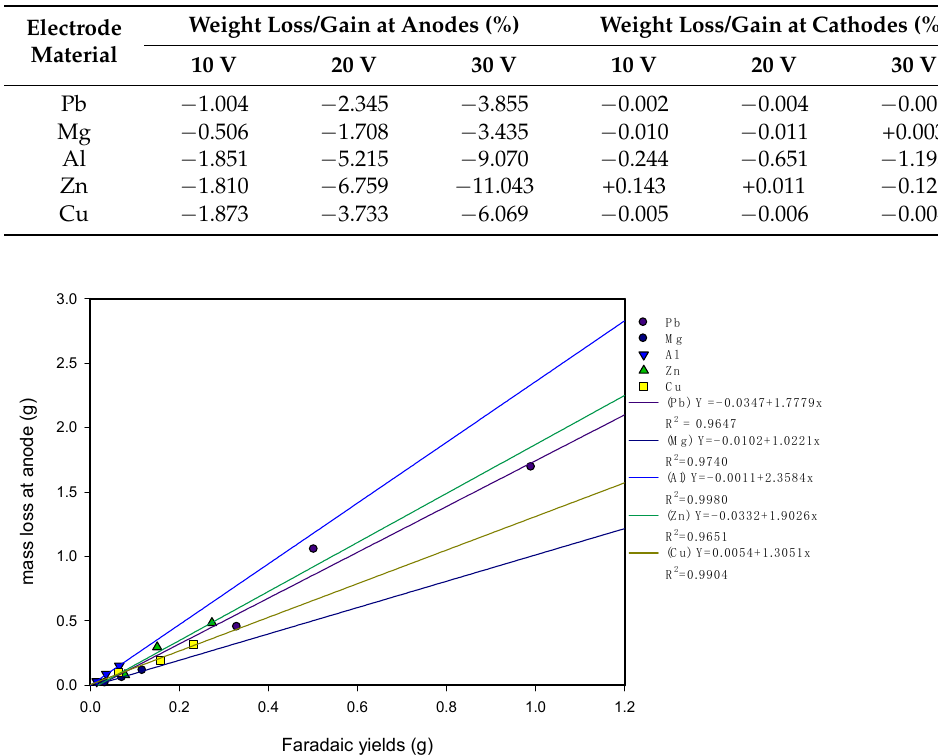
Table 4. Weight loss/gain at the anodes and cathodes after electrocoagulation.